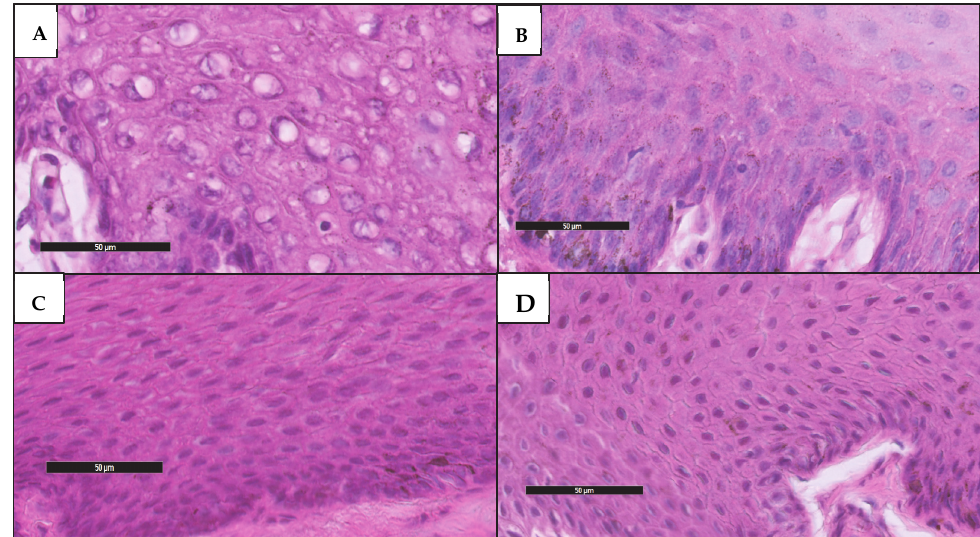
Figure 8. Photomicrographs of a hematoxylin–eosin-stained section of lower 1/3rd of epithelium at 48 h (40×): ( A ) 0.9% saline; ( B ) 10% formalin; ( C ) 6.6% propolis; ( D ) 6.6% propolis followed by 10% formalin.